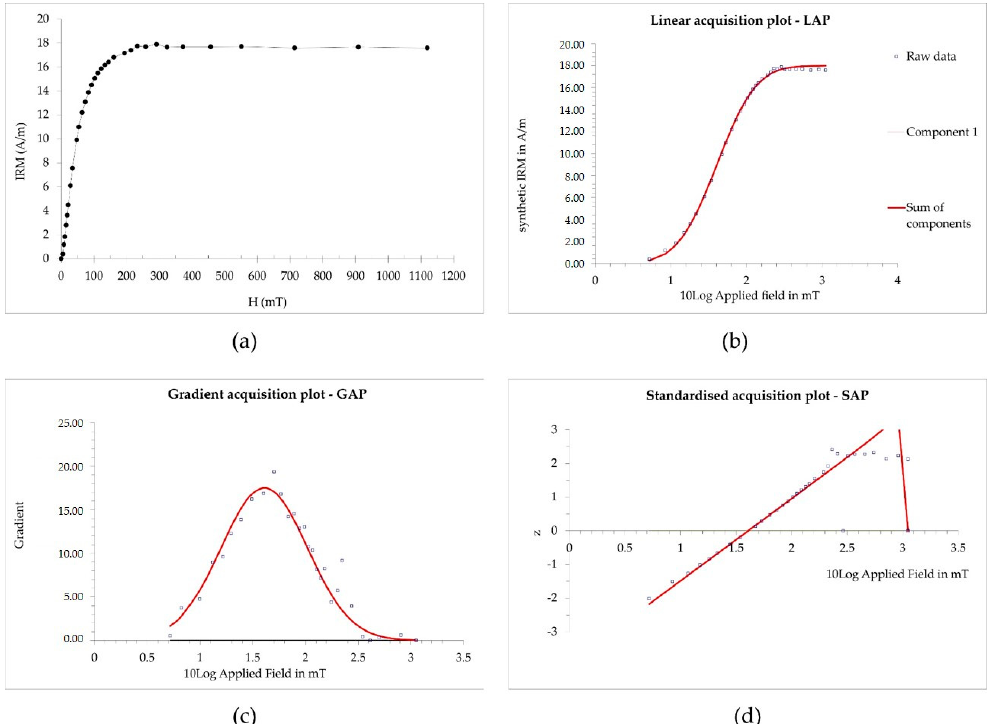
Figure 4. Analyses of ES18-A1 sample using the Kruiver et al. software [1]. ( a ) IRM acquisition curve analyzed using a Cumulative Log-Gaussian (CLG) function. ( b ) IRM curve adjustment versus the logarithm of the field applied to a linear scale (LAP). ( c ) IRM curve adjustment versus the logarithm of the field applied expressed as a gradient (GAP). ( d ) IRM curve adjustment versus the logarithm of the field applied to a probability scale (SAP).